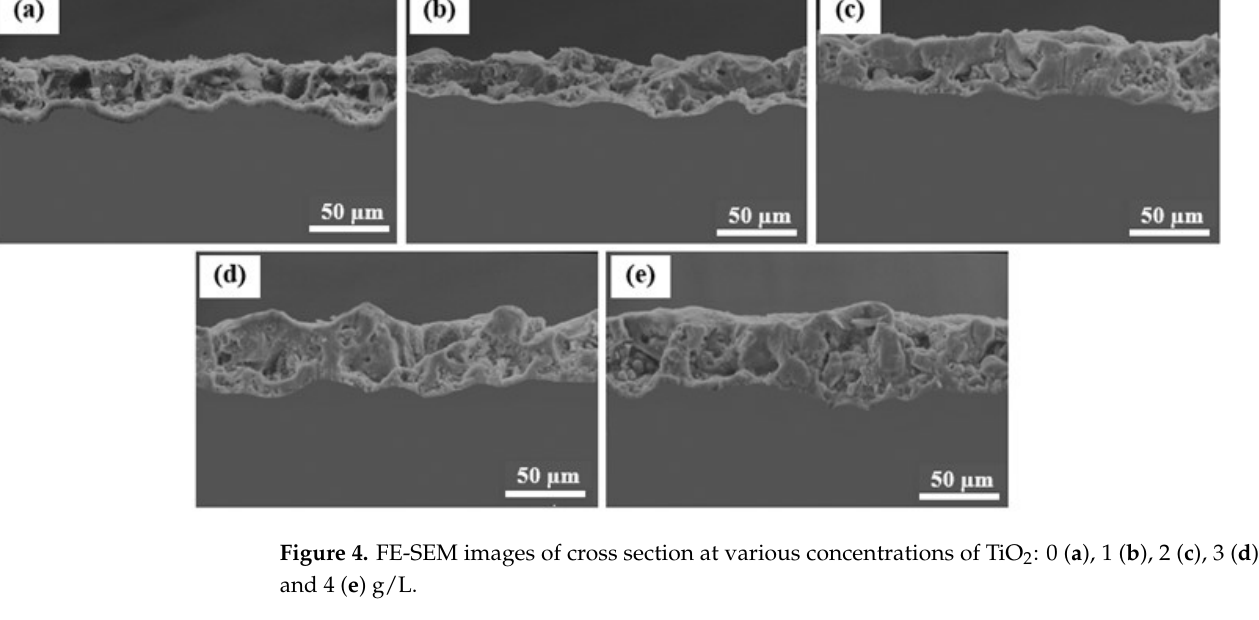
Figure 3. The average percentage of porosity and the average size of porosity with increasing concentration of TiO 2 NPs.